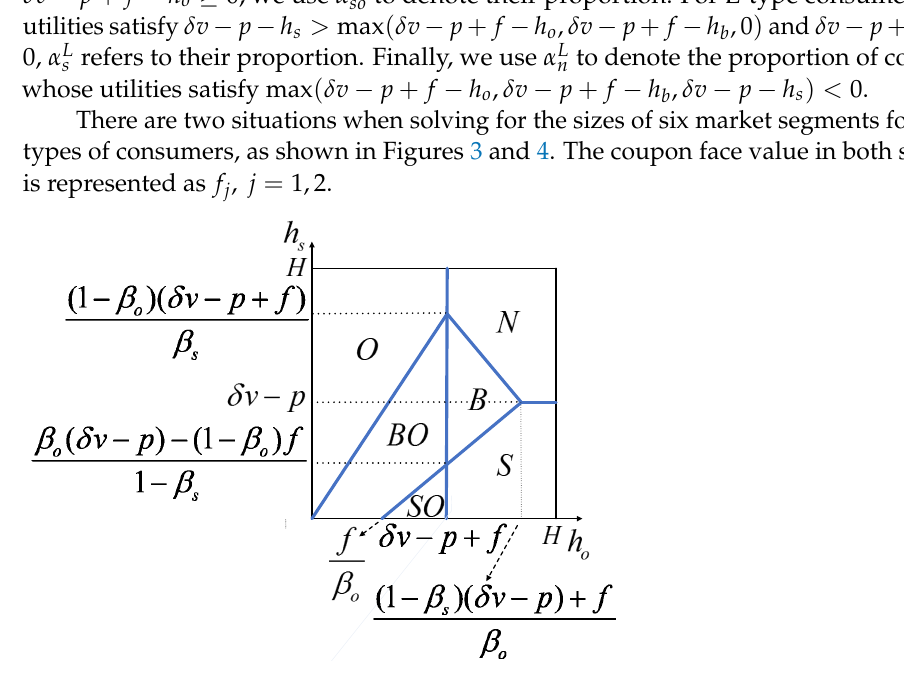
Figure 3. Market segmentation of L-type consumers when coupons are offered and 1